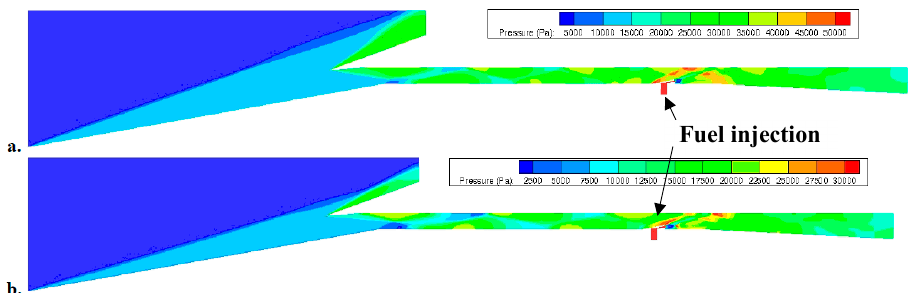
Figure 11. Static pressure contour obtained by Smayda; ( a ) at Mach 5 and ( b ) at Mach 7.